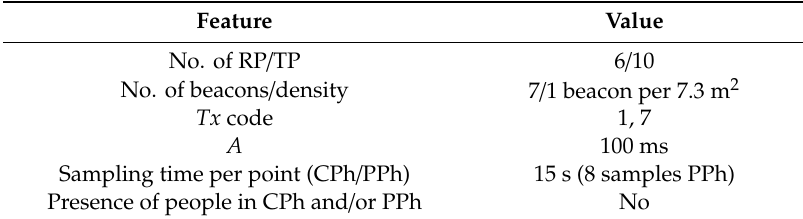
Table 20. Main features of Tests #7.